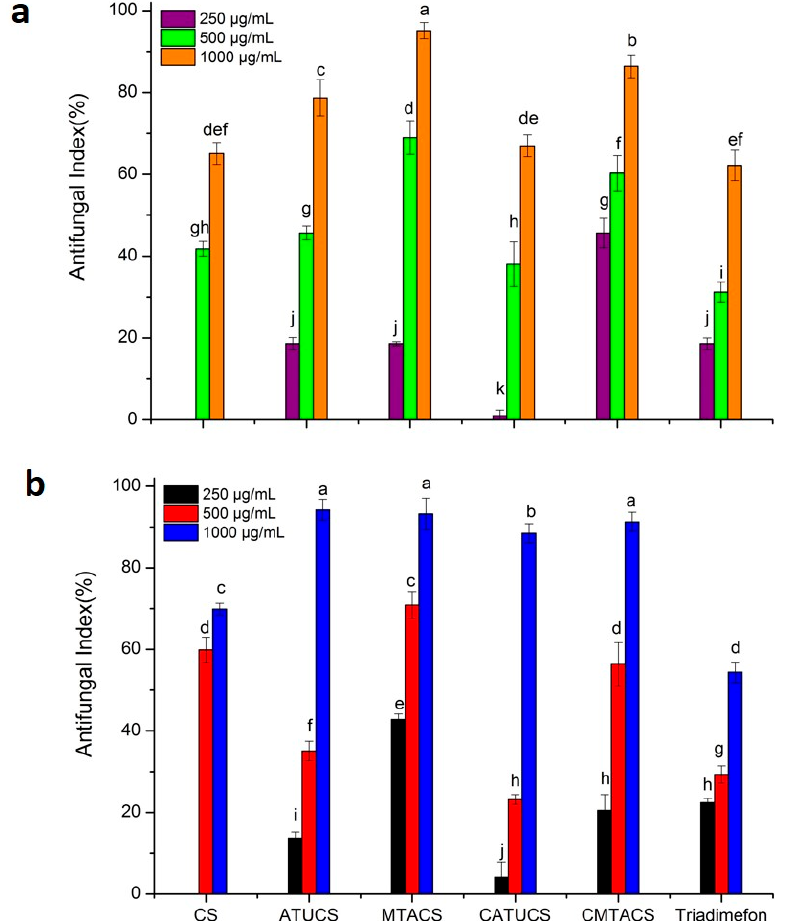
Figure 6. Inhibitory effect of chitosan (CS), acetyl thiourea chitosan (ATUCS), 3-methyl-1,2,4-triazolyl chitosan (MTACS), chloracetyl thiourea chitosan (CATUCS) and 3-chloromethyl-1,2,4-triazolyl chitosan (CMTACS) derivative on A. porri ( a ) and G. theae-sinensis ( b ).